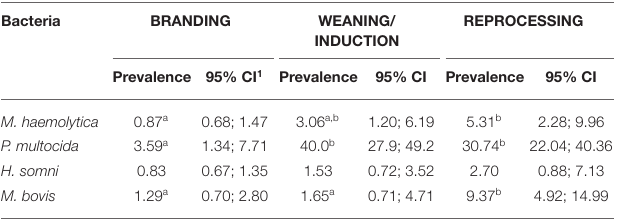
TABLE 3 | Prevalence per 100 animals of Mannheimia haemolytica, Pasteurella multocida, Histophilus somni , and Mycoplasma bovis at BRANDING ( n = 660